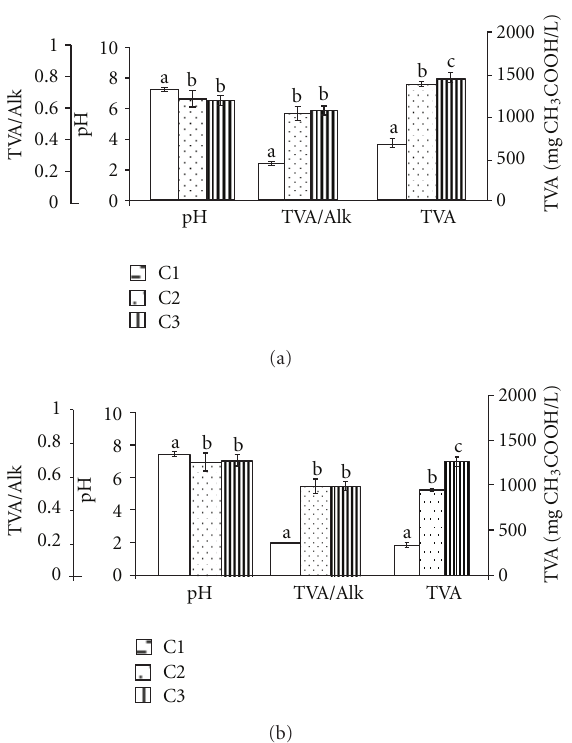
Figure 4: Process stabilities in (a) the sludge zone and (b) the packed zone of